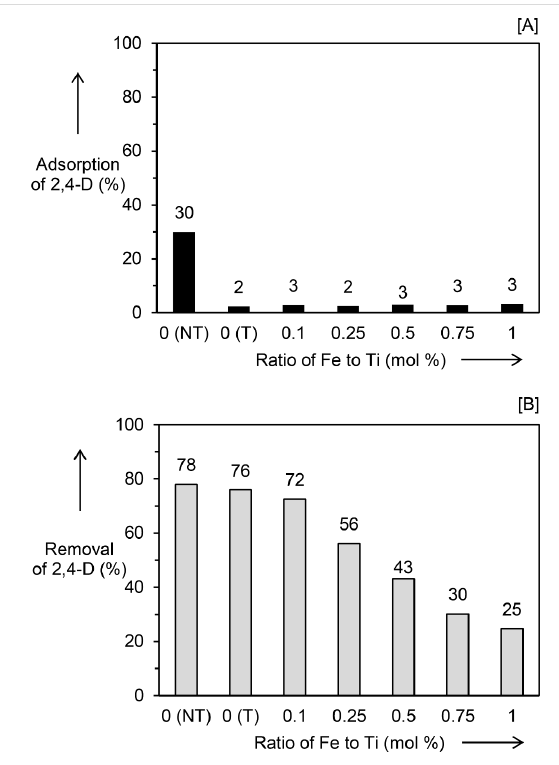
Figure 2: (A) Adsorption and (B) photocatalytic removal of 2,4-D over TiO 2 (NT), TiO 2 (PD_T) and a series of Fe 2 O 3 /TiO 2 (PD) samples. Error bars in (B) are shown for comparison purposes. NT represents no treatment, PD shows the samples were prepared by photodeposi- tion method, and T indicates an additional photodeposition treatment was carried out on the